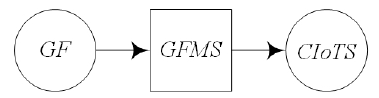
Figure 12. Controlling IoT services